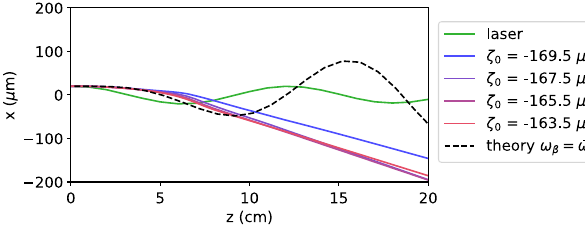
FIG. 7. Beam resonance with ω β ≃ ¯ ω . The green line shows the laser pulse centroid position, and other lines show the transverse position of different slices of the electron beam. The black dashed line shows the theory for the beam position when the resonance condition is met. Simulation conditions are given in Table I, except ¼ 156 GeV. The initial transverse the initial beam energy E beam position of the laser pulse and electron beam is ¯ x 0 ¼ X 0 ¼ 20 μ